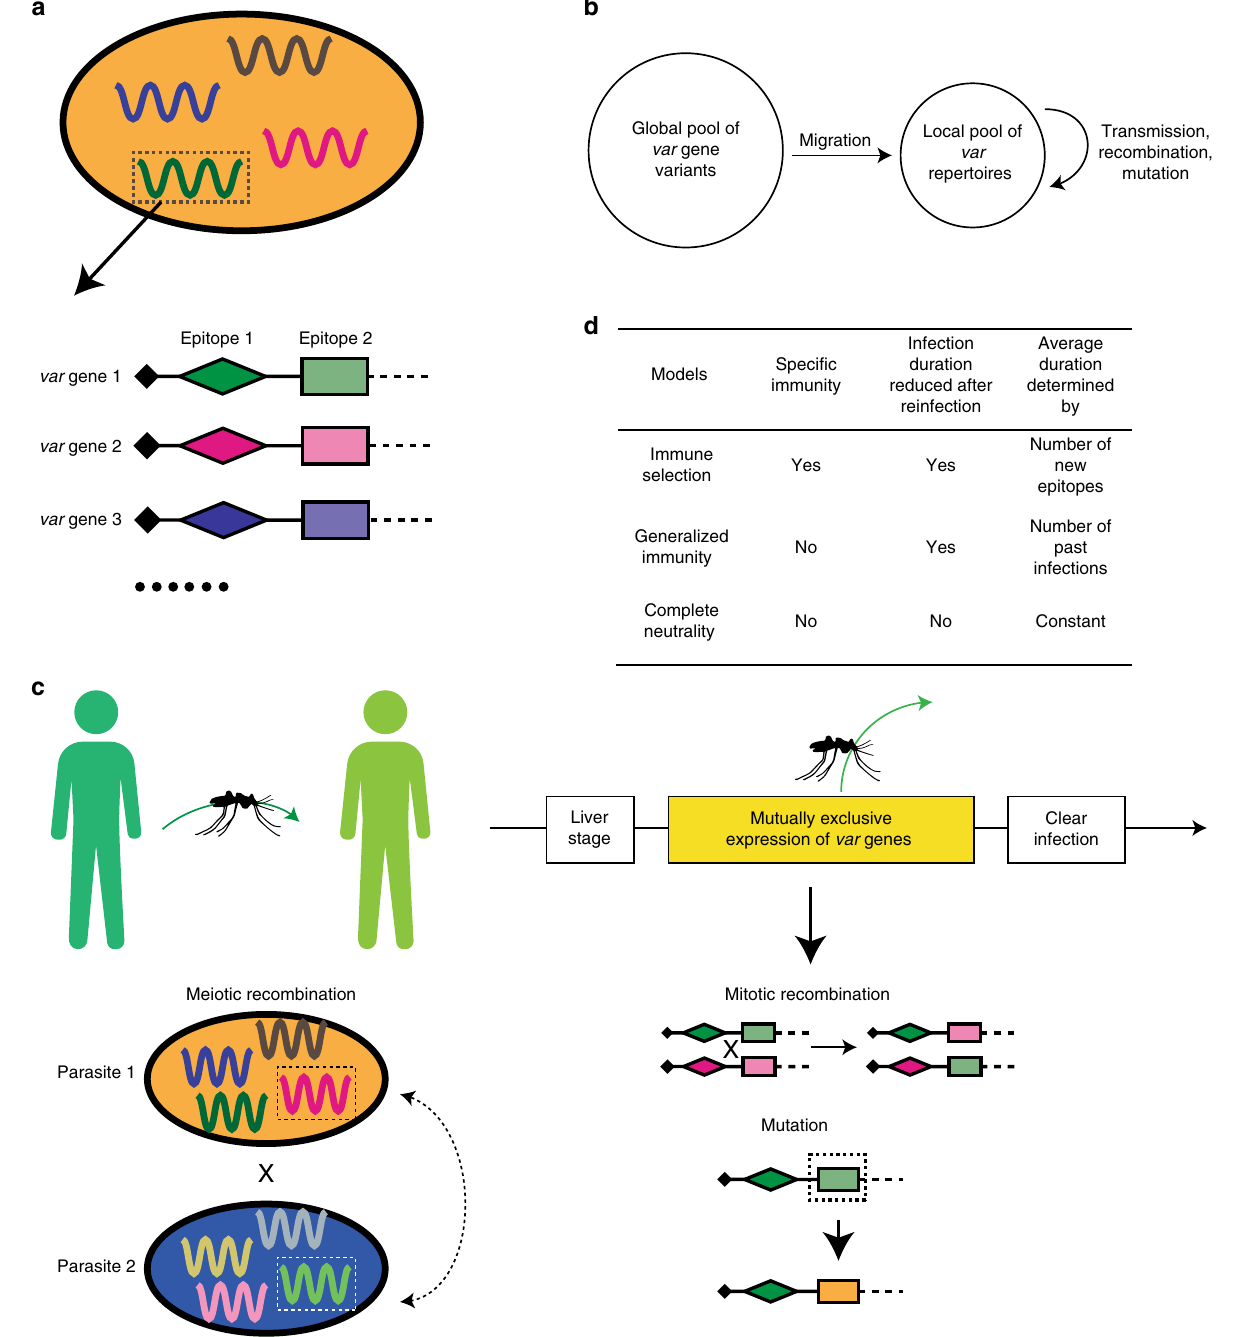
Fig. 1 Schematic illustration of the var gene model. a Each parasite genome (ovals) consists of a repertoire of g copies of var genes. Each var gene (depicted by different colors within each parasite) is in turn represented as a linear combination of epitopes (depicted by different shapes), with each epitope having many possible variants (alleles, depicted by different colors). b The local population receives var repertoires from a fi xed global var gene pool through migration. c At each transmission event, one donor and one receiver host are selected at random from the host pool. Each parasite genome in the donor host is transmitted to the mosquito with probability of 1/(number of genomes). During the sexual stage of the parasite (within mosquitoes), different parasite genomes can exchange var repertoires through meiotic recombination to generate novel recombinant repertoires. The receiver host can receive either recombinant genomes or original genomes. During the asexual reproduction stage of the parasite (within the blood stage of infection), var genes within the same genome exchange epitope alleles through mitotic (ectopic) recombination. Also, epitopes can mutate. These two processes generate new var genes. Each var gene is expressed sequentially and the infection ends when all the var genes in the repertoires have been expressed. A new transmission event may occur throughout the period of expression of var genes as the result of biting events. d Comparison of the three different models. Only the immune selection model includes speci fi c immunity, through the dependence of infection duration on the memory of previous alleles that have been seen by a given host. For meaningful comparisons, all the models have the same mean duration of